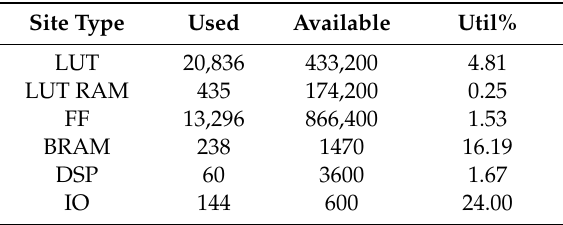
Table 7. Resource utilization report of